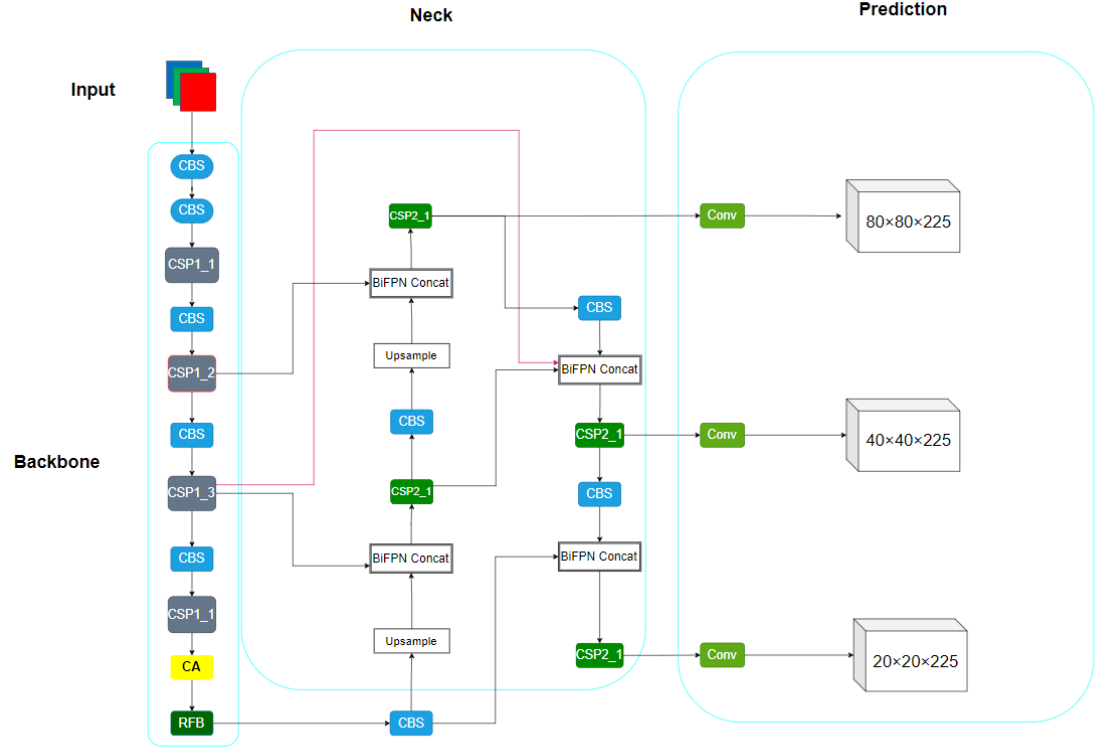
Figure 6. The structure of improved forest fire smoke detection model.